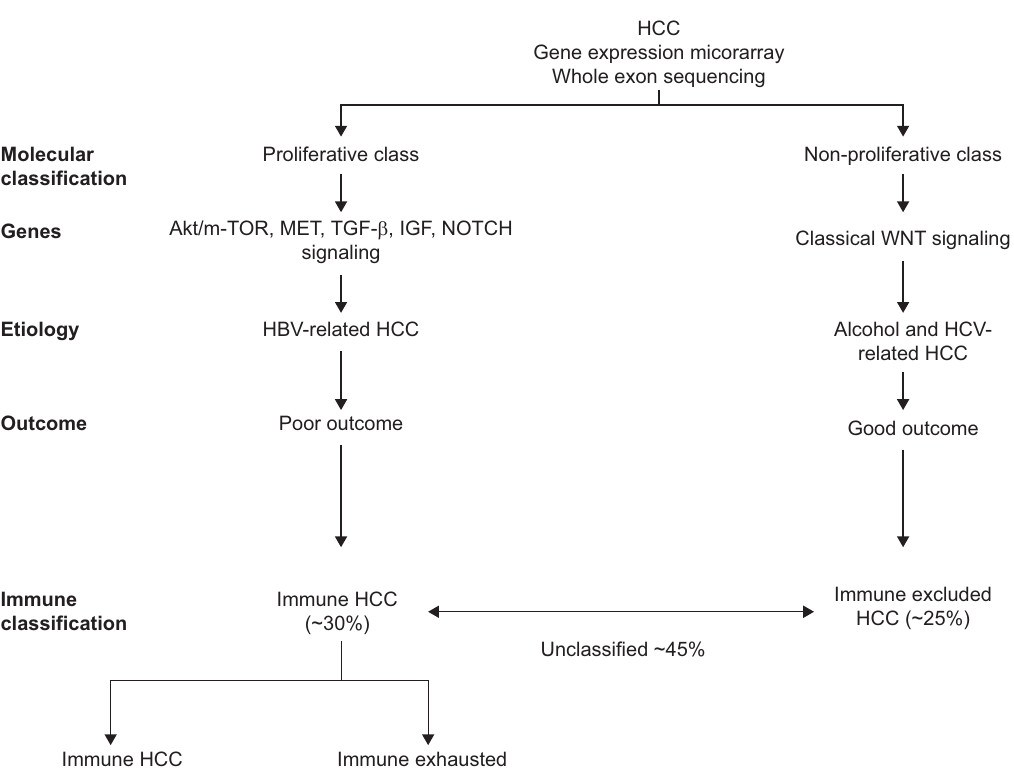
Figure 1: Molecular classification of HCC. Proliferation and non-proliferation class are characterized by mutations in different genes and associated with patients’